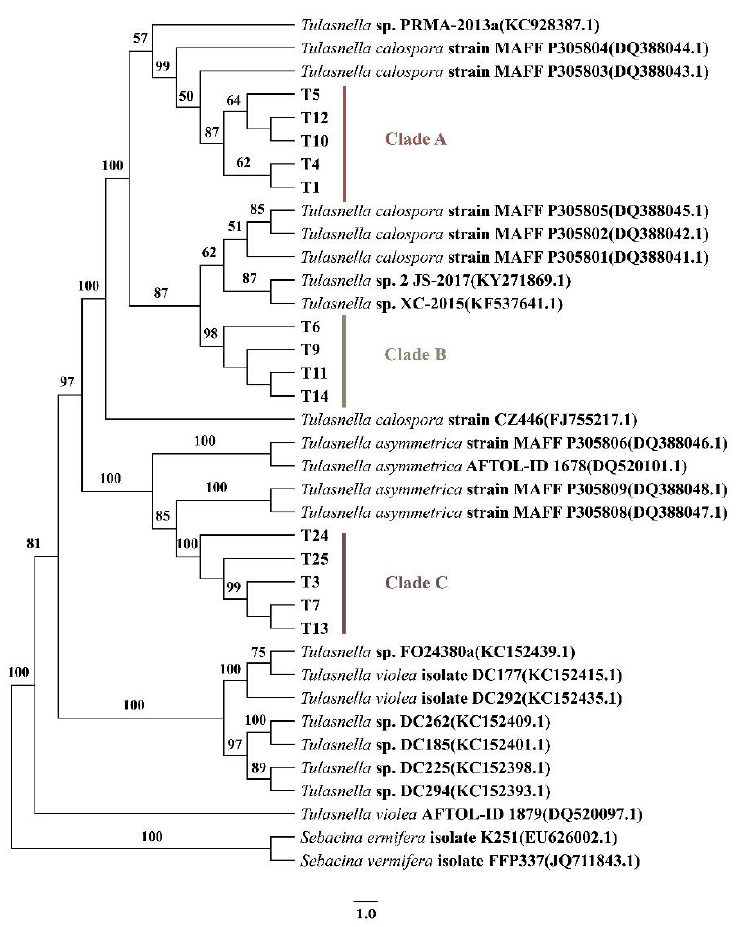
Figure 2. Maximum likelihood trees of ITS sequences of Tulasnella sp. The sequence of Sebacina vermifera isolate FFP337 and Sebacina vermifera isolate K251 was used as an outgroup. Only bootstrap values (based on 1000 replications) ≥ 50 are shown. Scale, 1.0 nt substitutions per site.